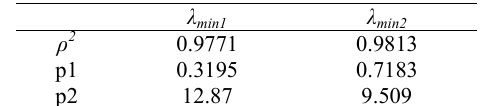
Table 4. Coefficients of determination, ρ 2 , and parameters of fitted curves ( 𝑦 = 𝑝1 × 𝑥 + 𝑝2 ) shown in Fig.